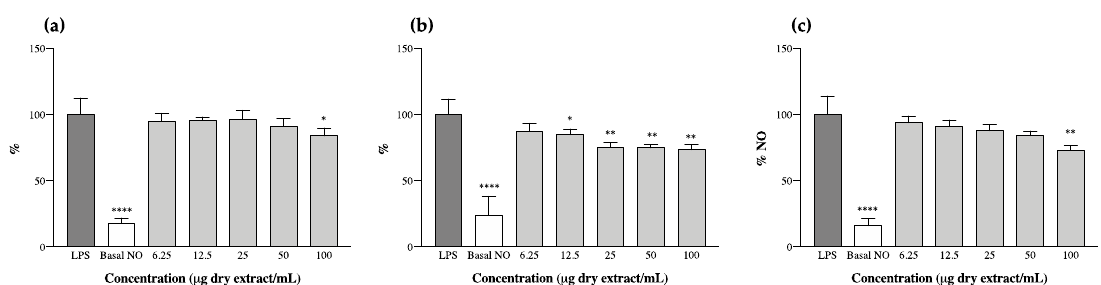
Figure 2. Nitric oxide (NO) production by RAW 264.7 cells in the presence of cyanobacteria acetone extracts after stimulation with lipopolysaccharide (LPS). ( a ) Alkalinema aff. pantanalense LEGE15481, ( b ) Nodosilinea (Leptolyngbya) antarctica LEGE13457 and ( c ) Leptolyngbya -like sp. LEGE13412. Results are expressed as % of NO relative to the control stimulated with LPS. Basal NO represents the NO produced by RAW 264.7 cells without LPS stimulation. Results are expressed as the mean ± SD of at least four independent assays, performed in duplicate. * p < 0.05, ** p < 0.01, **** p < 0.0001 (ANOVA, Tukey HSD).